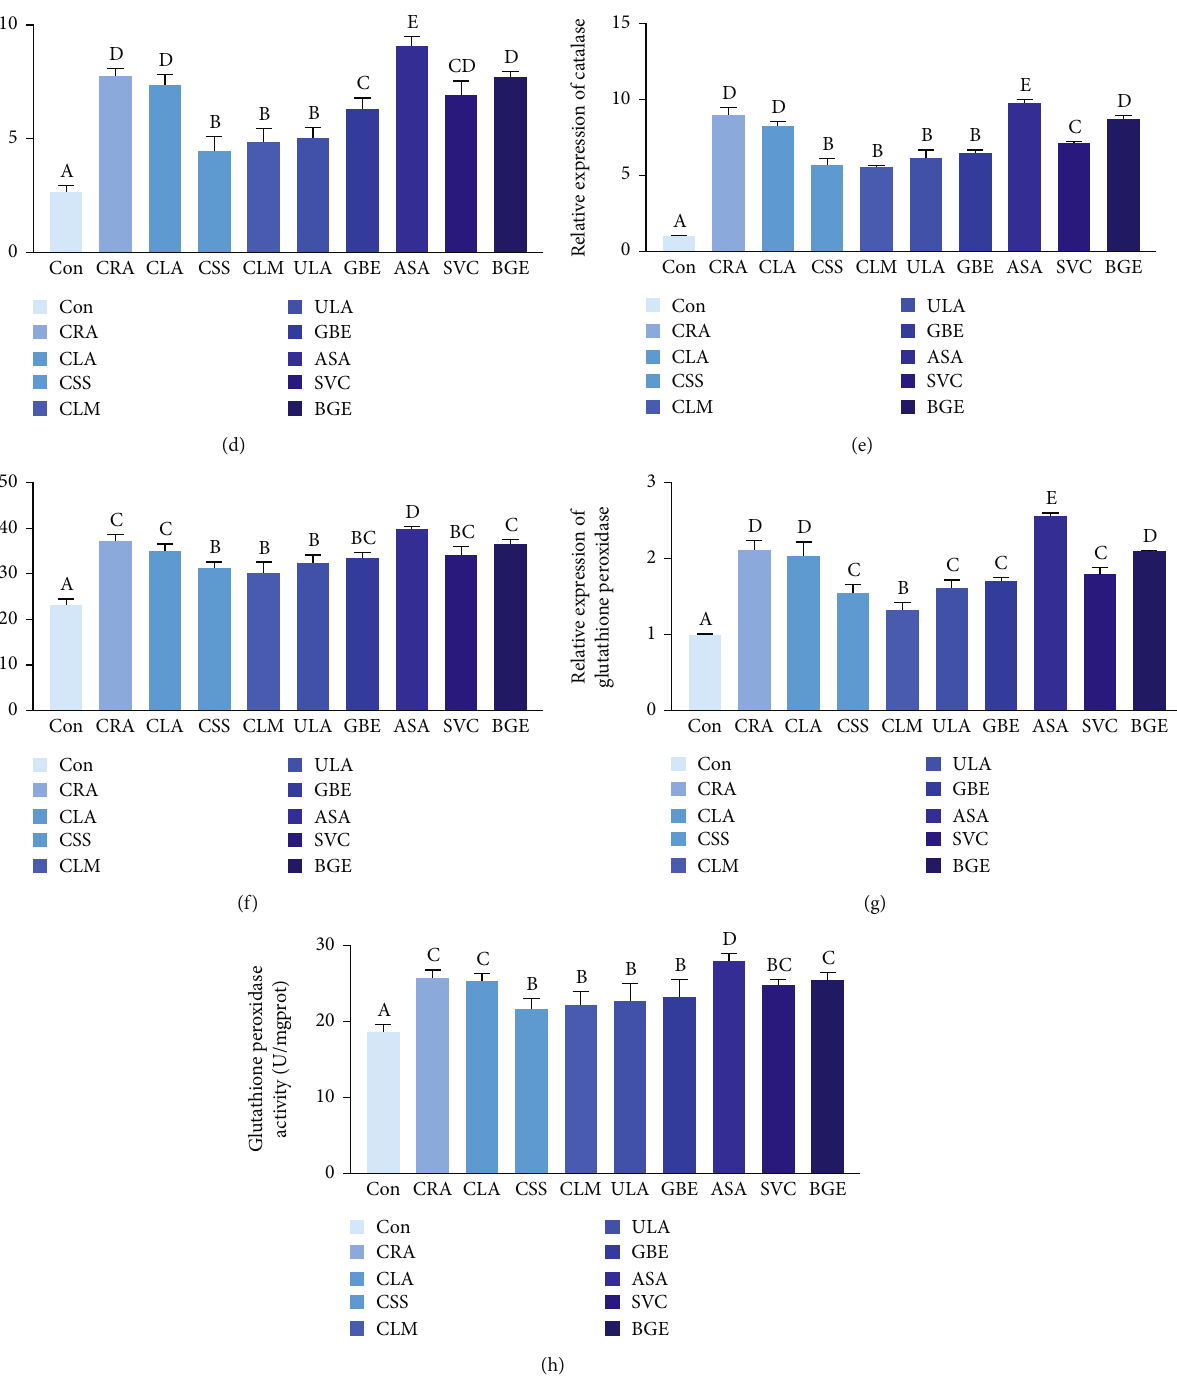
Figure 4: E ff ects of macroalgae diet on the antioxidant capacity of L. vannamei . Total antioxidant capacity (a), malonaldehyde activity (b), relative expression of superoxide dismutase (c), superoxide dismutase activity (d), relative expression of catalase (e), catalase activity (f), relative expression of glutathione peroxidase (g), and glutathione peroxidase activity (h) of L. vannamei in di ff erent groups. All data were expressed as mean ± SE ( n = 3 ). The mean column with di ff erent superscript letters (A – E) showed a signi fi cant di ff erence ( P < 0 : 05